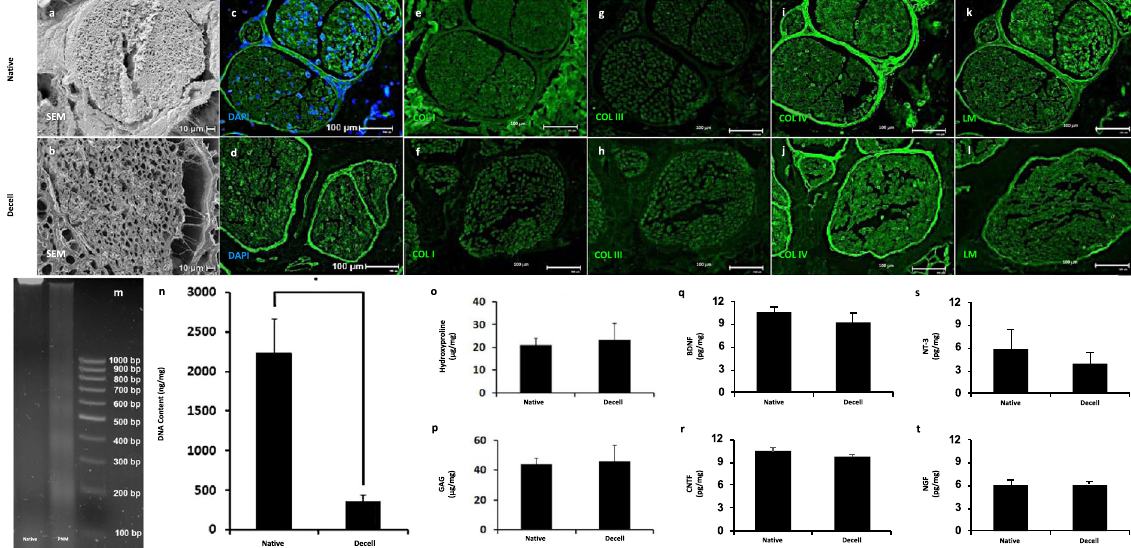
Fig. 2 Characterization of decellularized porcine peripheral nerve. SEM imaging before a and after b decellularization showed that the structure of the nerve was maintained following the decellularization process. Scale bars 10 µm. DAPI labeling of native c and decellularized d tissue showed the removal of nuclei in the decellularized samples. Additional labeling for collagen I ( e , f ), III ( g , h ), IV ( i , j ), and laminin ( k , l ) showed strong maintenance of key nerve proteins collagen IV and laminin in the decellularized samples. Scale bars 100 µm. An agarose gel was used to assess the fragmentation of any remaining DNA within the sample ( m ) and a PicoGreen assay ( n ) was used to demonstrate a signi fi cant (* p < 0.001) reduction in dsDNA content. Biochemical assays were used to demonstrate the maintenance of hydroxyproline ( o ) and GAG ( p ) content. ELISA assays were used to assess the maintenance of nerve growth factors BDNF ( q ), CNTF ( r ), NT-3 ( s ), and NGF ( t ). Data are presented as mean ± SD. All blots were derived from the same experiment and processed in (Fig. 2b). The original structures, including endoneurium and